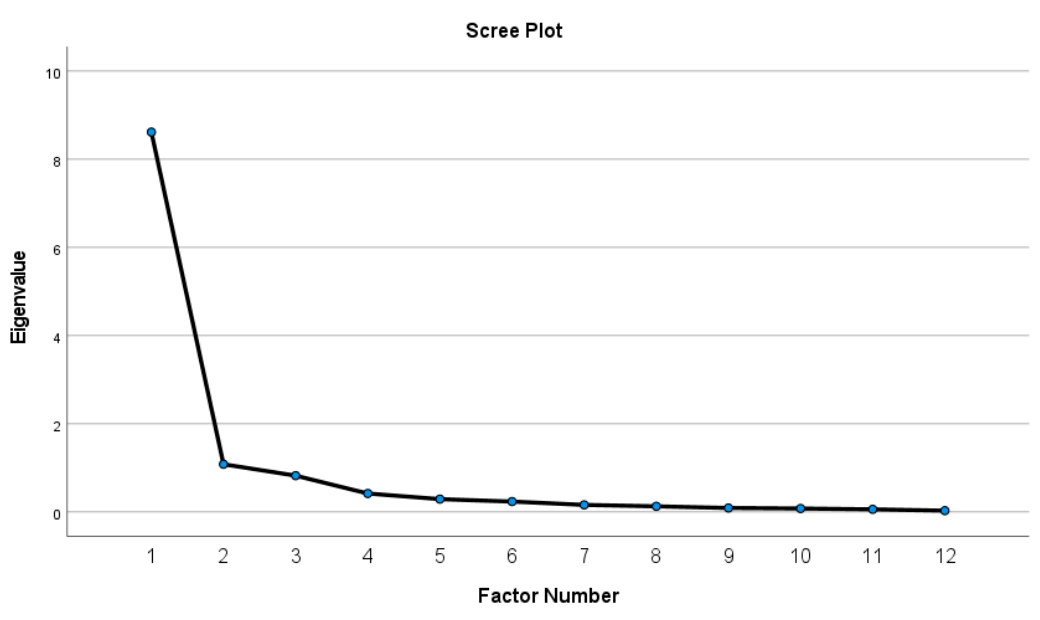
Figure 3. Scree Plot for Exploratory Factor Analysis.